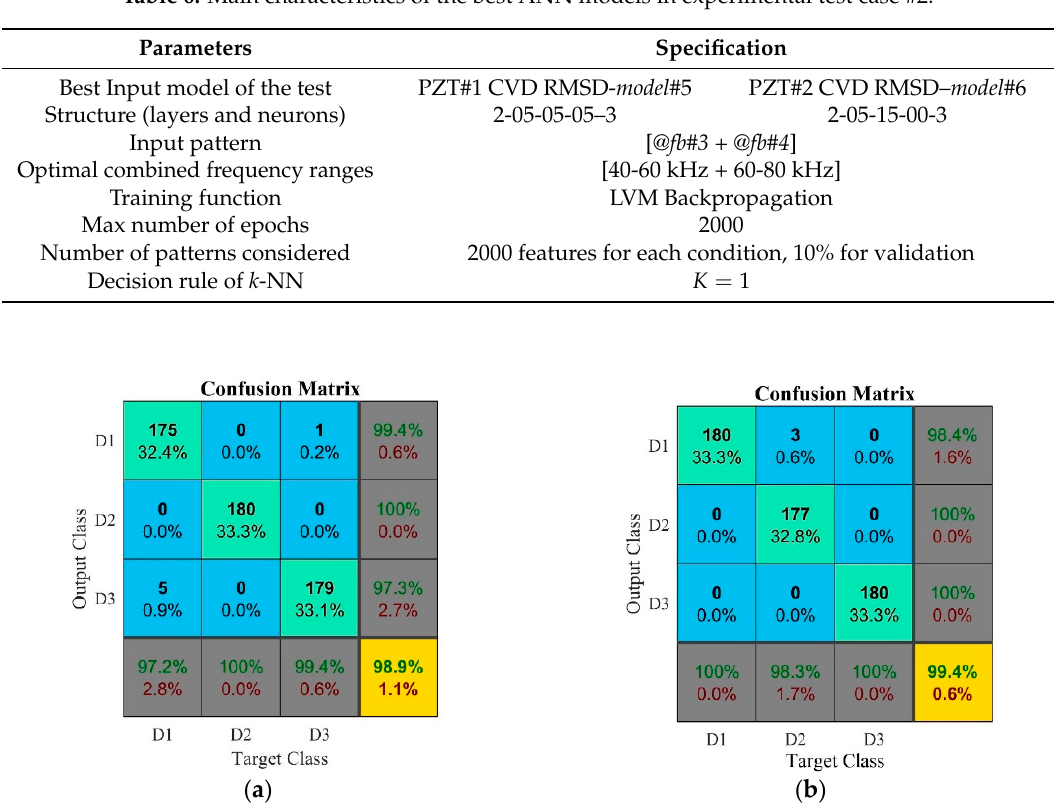
Table 6. Main characteristics of the best ANN models in experimental test case #2.